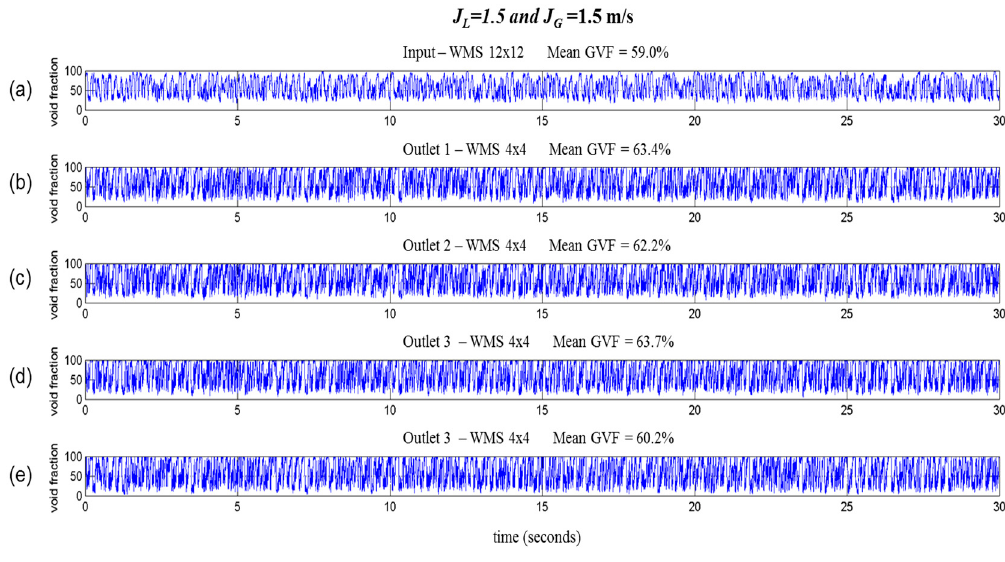
Figure 11. Void fraction time series (30 s. J L = 1.5 m/s and J G = 1.5 m/s): ( a ) Input and ( b – e ) outlets 1 to 4.